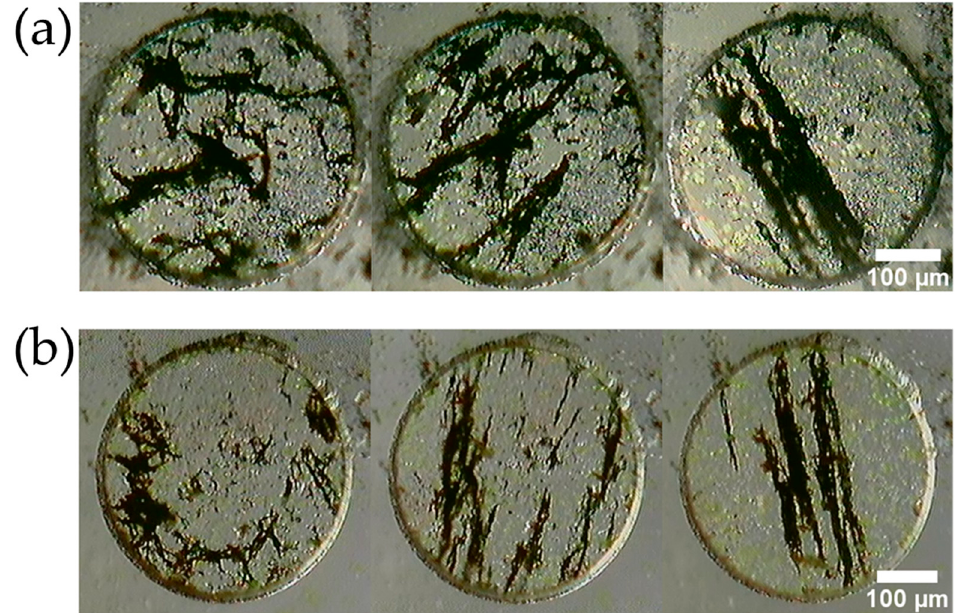
Figure 8. Shape change of the fabricated powder. ( a ) Powder of neodymium magnet. ( b ) Powder of magnet sheet.